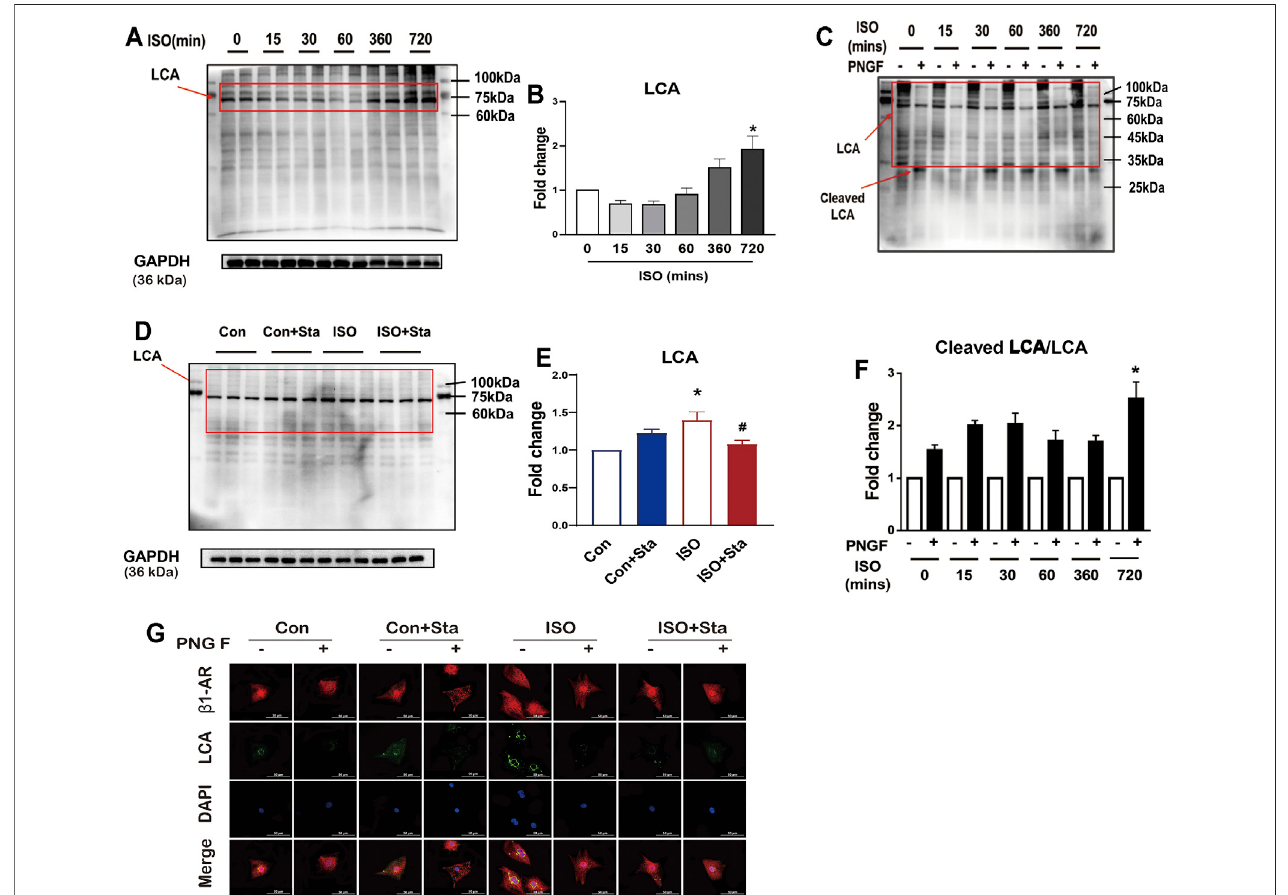
FIGURE8| StachydrinehydrochloridereducedISO-inducedcardiacN-linkedglycoproteinswith α -1,6-fucosylation invitro . (A,B) RepresentativeWesternblotand quanti fi cation of LCA exposed to ISO at different time points in NRVMs (from three independent experiments). (C,D) Representative Western blot and quanti fi cation of LCA after PNGase F digestion exposed to ISO at different time points in NRVMs (from three independent experiments). (E,F) Representative Western blot and quanti fi cation of Sta on cAMP production and PKA activity exposed to ISO at 720 min (from three independent experiments). (G) Representative immuno fl uorescence of LCA and β 1AR exposed to ISO at different time points in NRVMs. The data are expressed as mean ± standard error of mean, * p < 0.05 versus control; # p < 0.05 versus ISO. ISO, isoproterenol; Sta, stachydrine hydrochloride; NRVMs, neonatal rat ventricular myocytes.